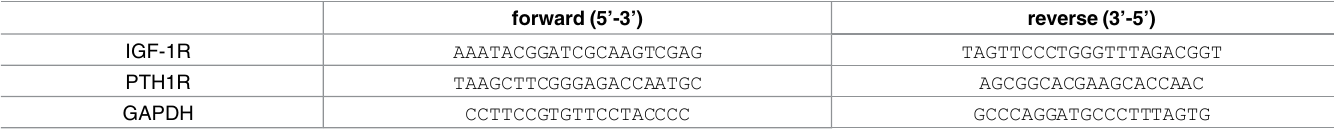
Table 2. IGF-1R and PTH1R RT-PCR